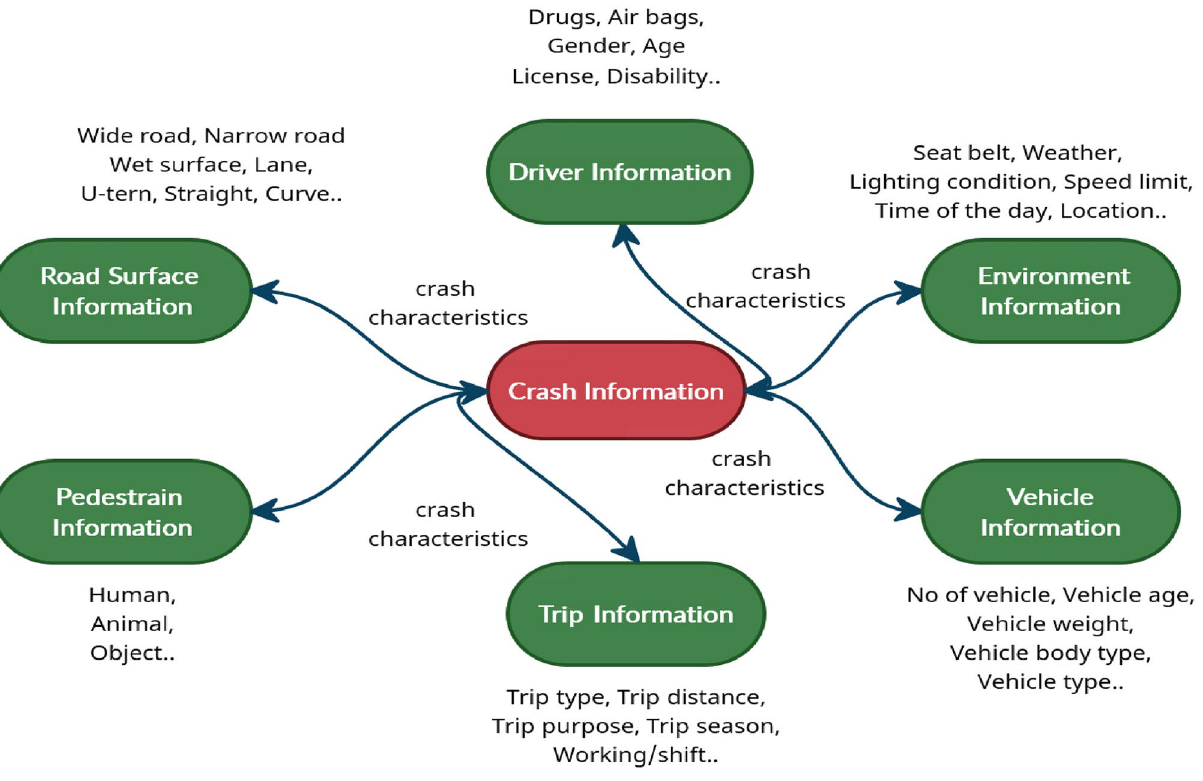
Figure 2. Responsible factors of crash